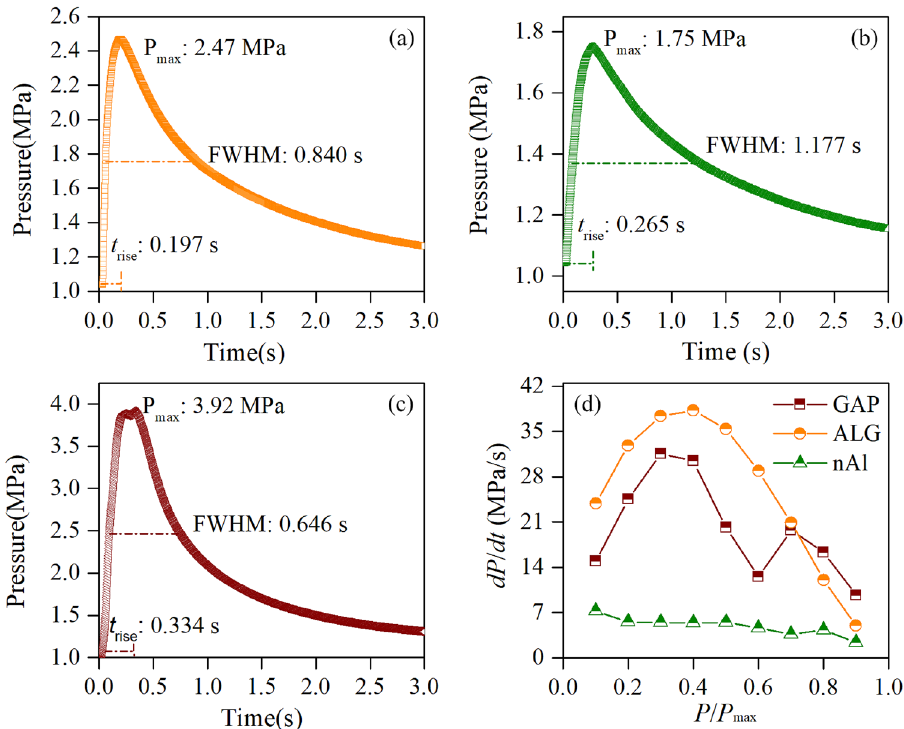
Figure 7. P –t curves of ( a ) ALG, ( b ) nAl and ( c ) GAP under 1 MPa oxygen environment; and their corresponding pressure evolvement histories ( d